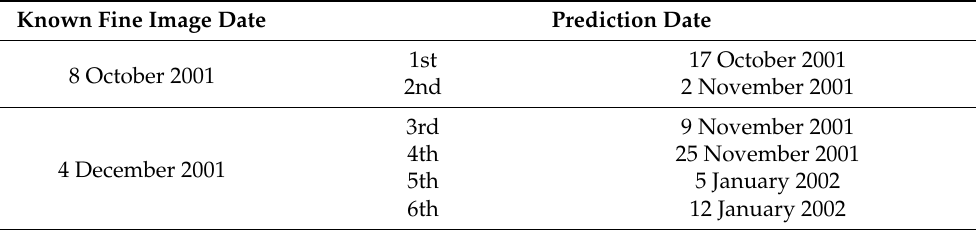
Table 1. Date and function of Landsat images in Experiment